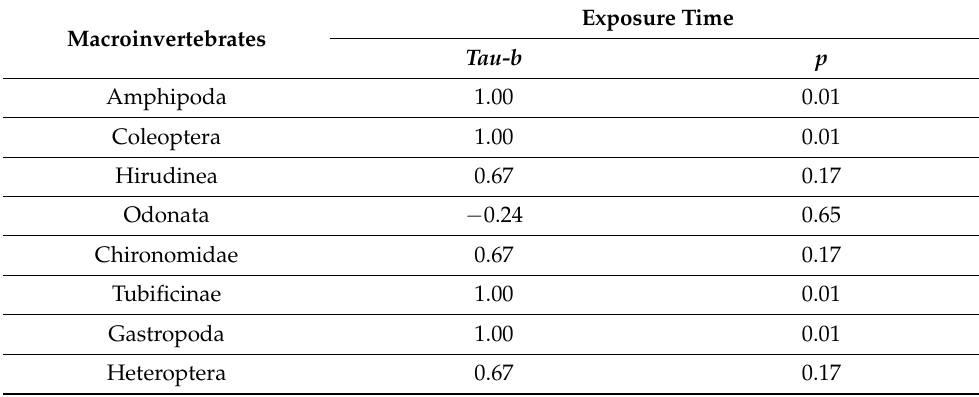
Table 2. Kendall’s tau-b correlation coefficient: exposure time vs macroinvertebrate abundance Tau-b —Kendall’s tau-b correlation coefficient, p — p